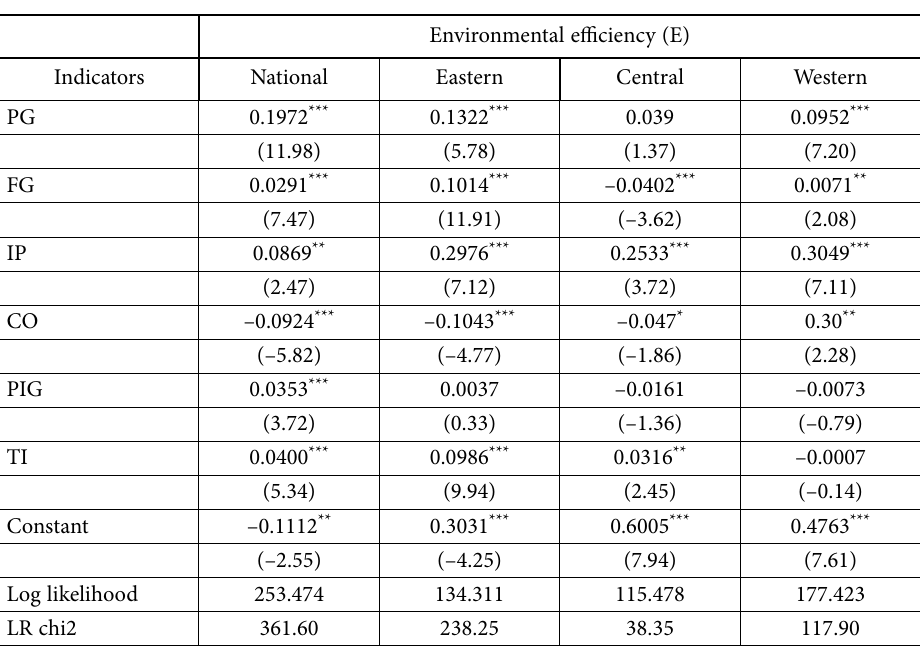
Table 8. Result of